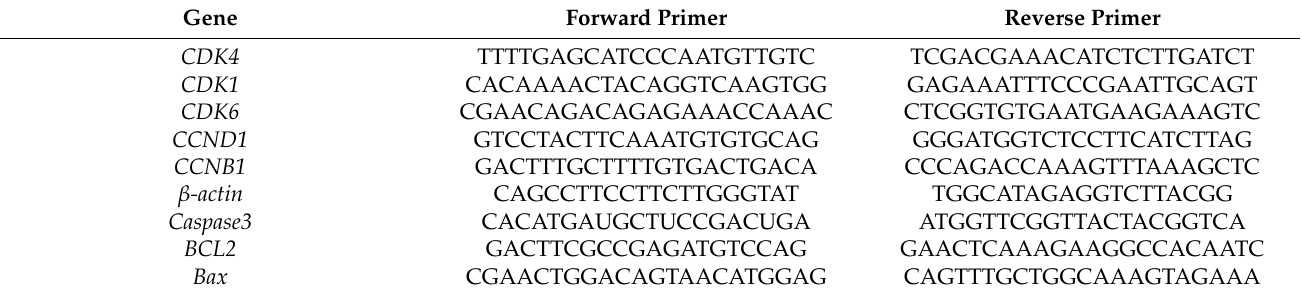
Table 3. Primers for RT-q